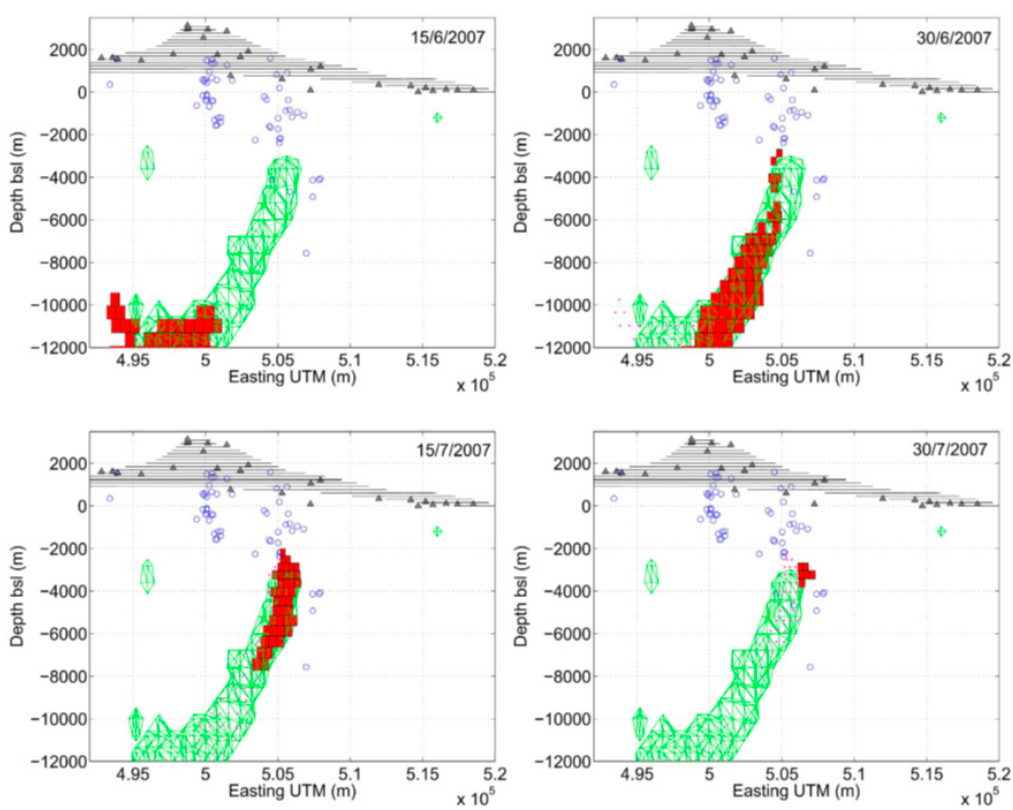
Figure 18. Model for the inflation phase. Cumulated magmatic body (in green) modelled for the period 1 January 2007 to 12 May 2008 and time evolution (in red) for the sub-period that corresponds to the months of June and July 2007, when the system was subject to a recharging episode, which appears as an ascending high-pressure body. Parallelepiped sources represent active point pressure sources within the same volume. Blue circles correspond to location of the earthquakes for 12–14 May 2008